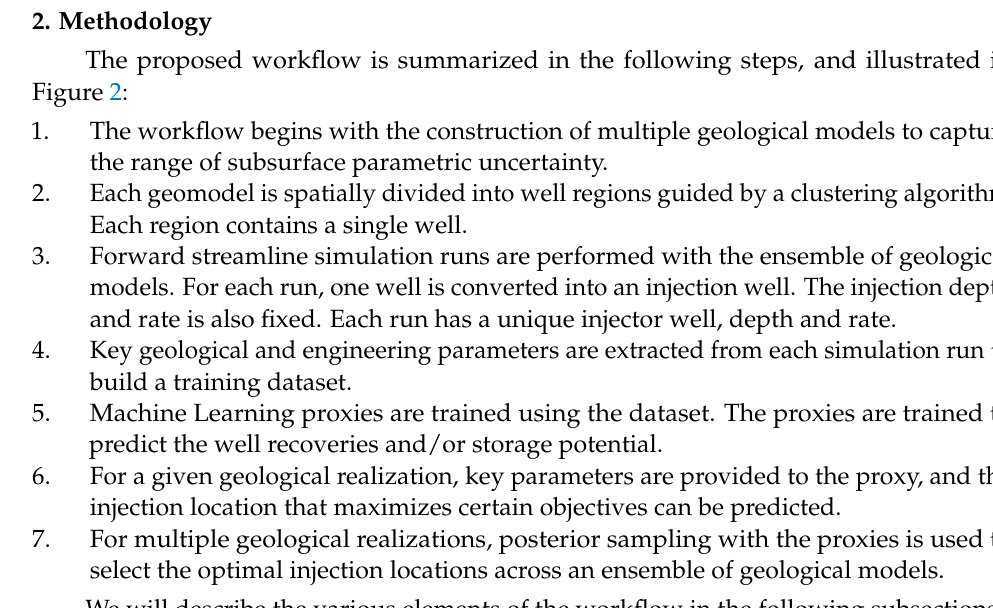
Figure 1. Illustration of the injector well selection challenge for a field with existing producers (black dots) ( a ) and an ensemble of geological realizations ( b